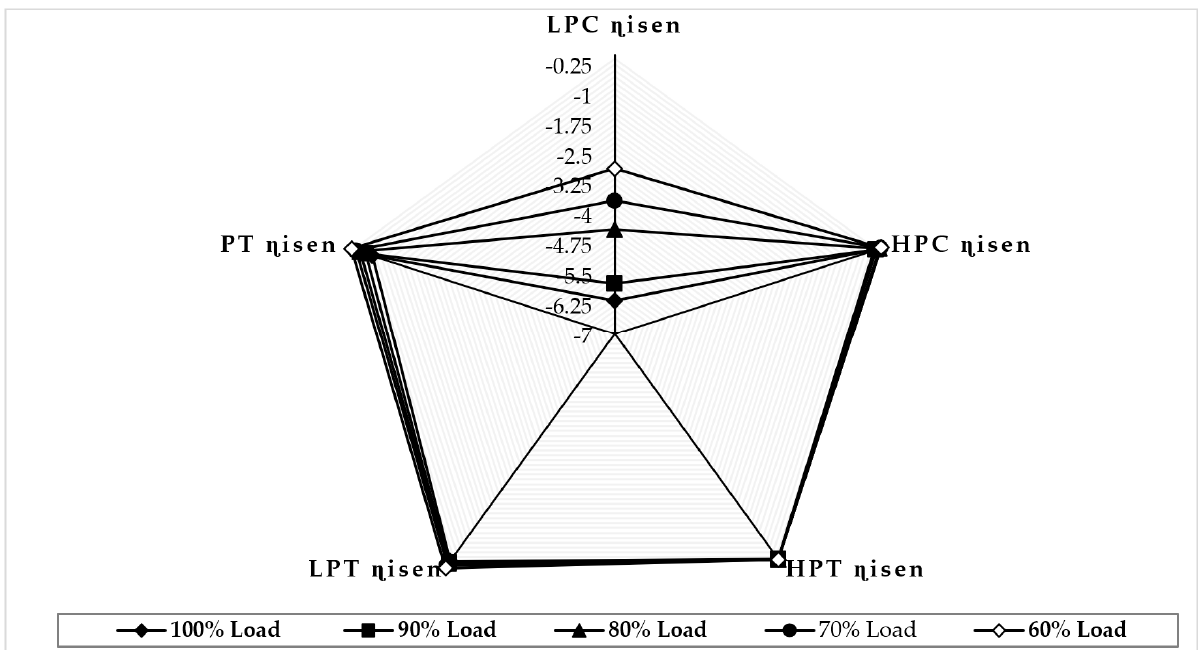
Figure 7. Deviation in component isentropic efficiency due to LPC fouling at 100% fault severity at full − load and part − load operation.